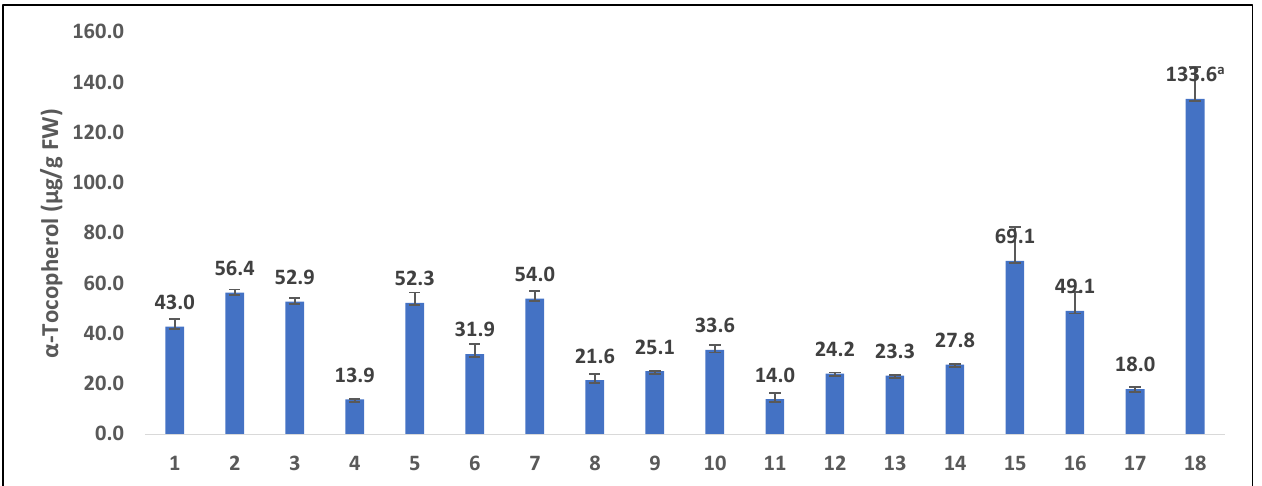
Figure 2. The contents of α-tocopherol in studied traditional GLVs. The results represent the average ± standard deviation (SD) obtained from three replicate analyses. The values with the superscript letter “a” show the highest ( p < 0.05, Tukey B HSD) contents among the various traditional GLVs. The numbers 1–18 on the X -axis represent the S/No. of samples in Table 1.